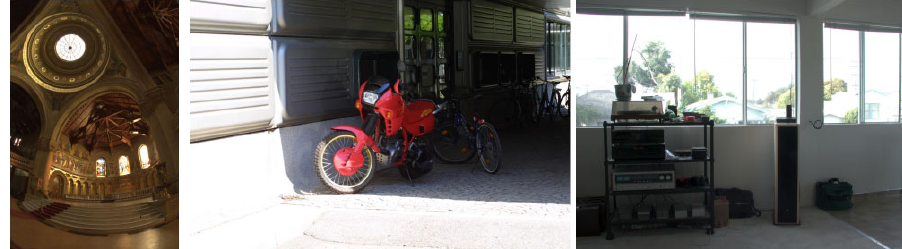
Figure 6. The picture shows the test radiance maps rendering on standard LCD. The left image, called “memorial church”, is an HDR image from TMQI database [19]. The middle image, called “moto”, and the right image, called “apartment”, are reprinted with permission from Ref. [24]. 2022